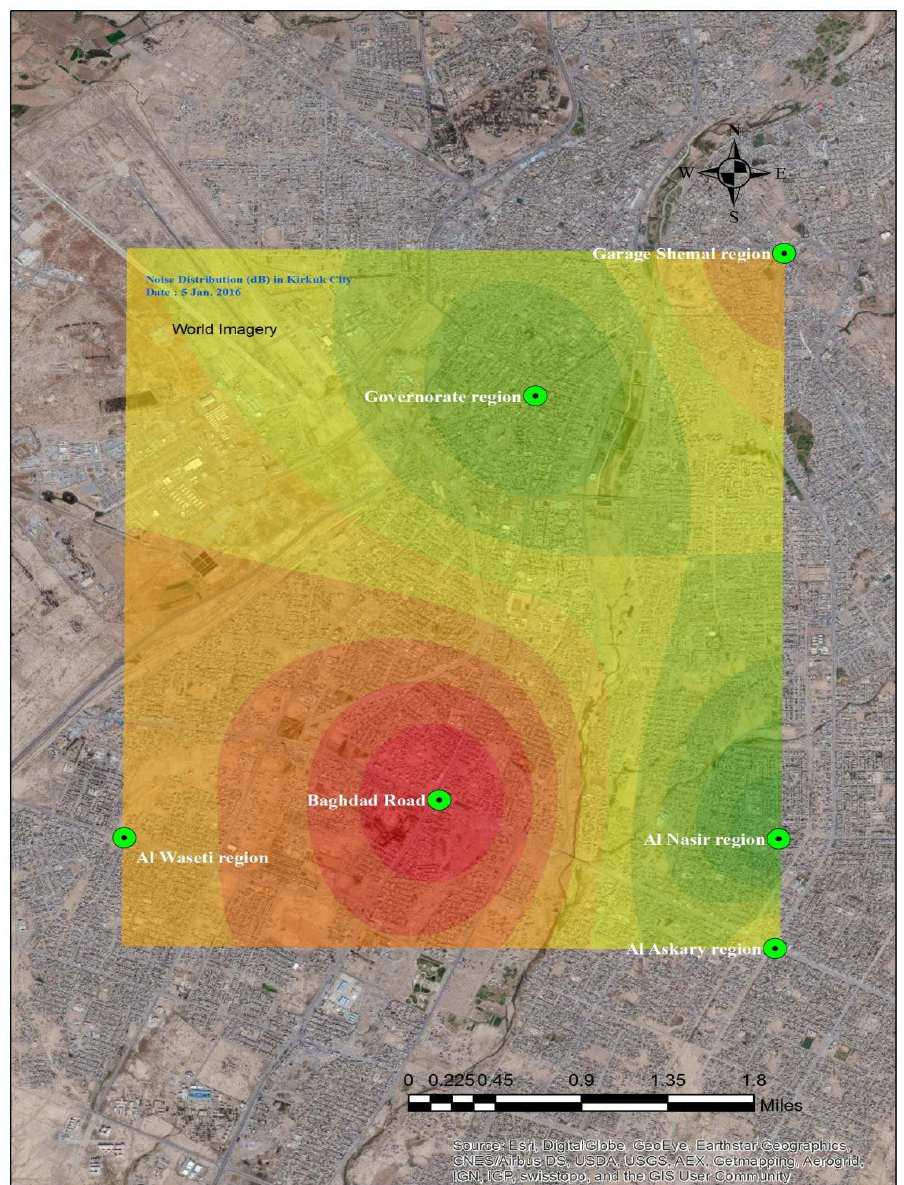
Fig. 6. Daily Noise Distribution for the peak morning and evening traffic flow 5 Jan. 2015 Kirkuk